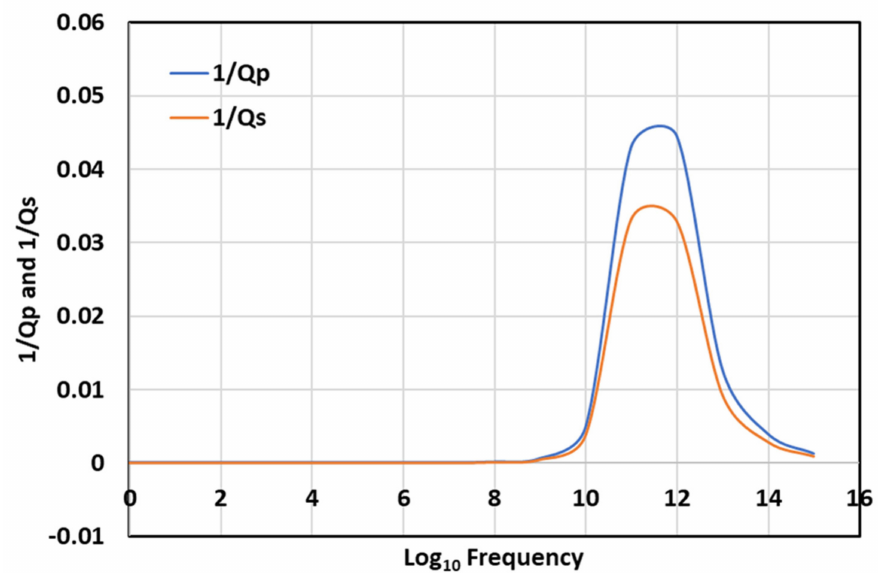
Figure 9. Cross plot of P-wave (blue) and S-wave (orange) attenuation based on Squirt-flow model versus log of frequency (Hz) for the Cotton Valley shale. Q p = P-wave quality factor, Qs = S-wave quality factor.